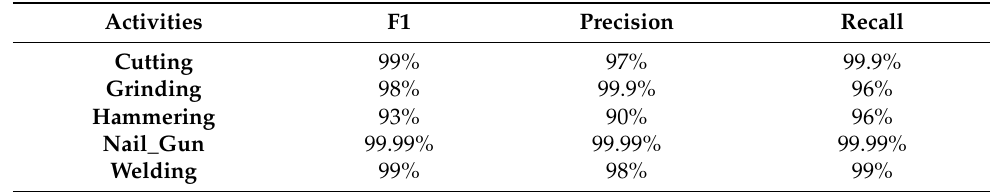
Table 3. The F1-score, precision and recall for individual construction activities.